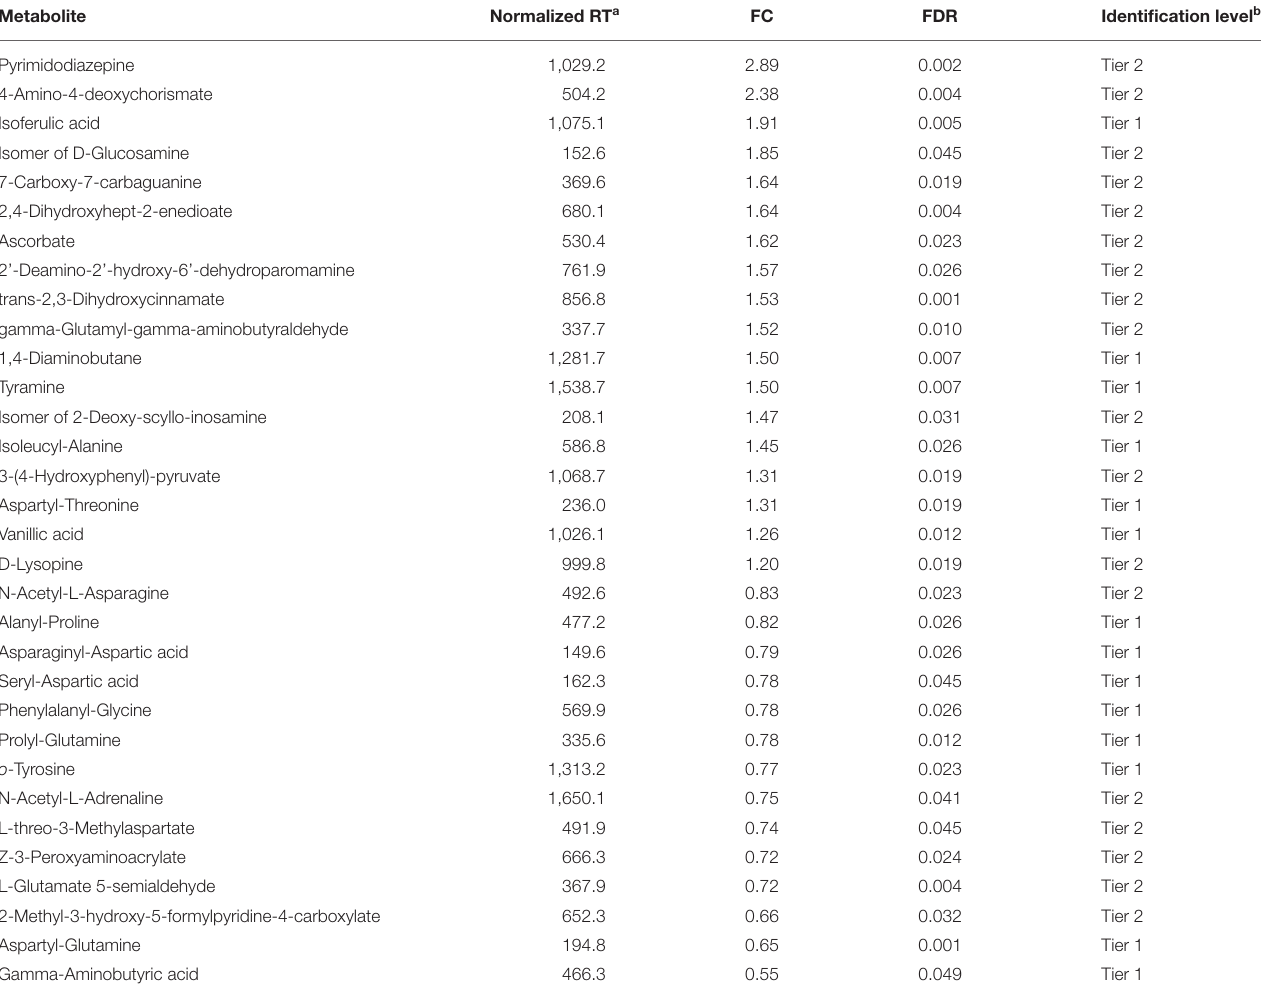
TABLE 1 | Identified amine/phenol-containing metabolites affected by cannabidiol (CBD) compared to control (CON).